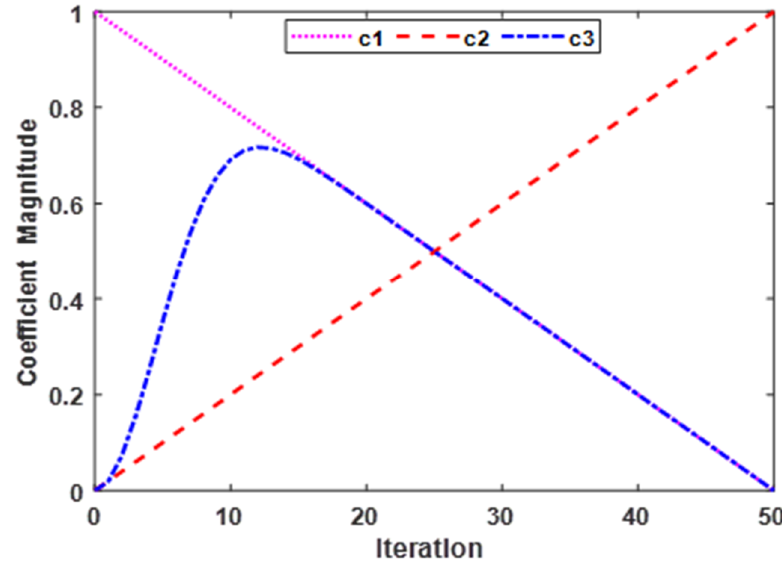
Figure 3. Behavior of acceleration coefficients during